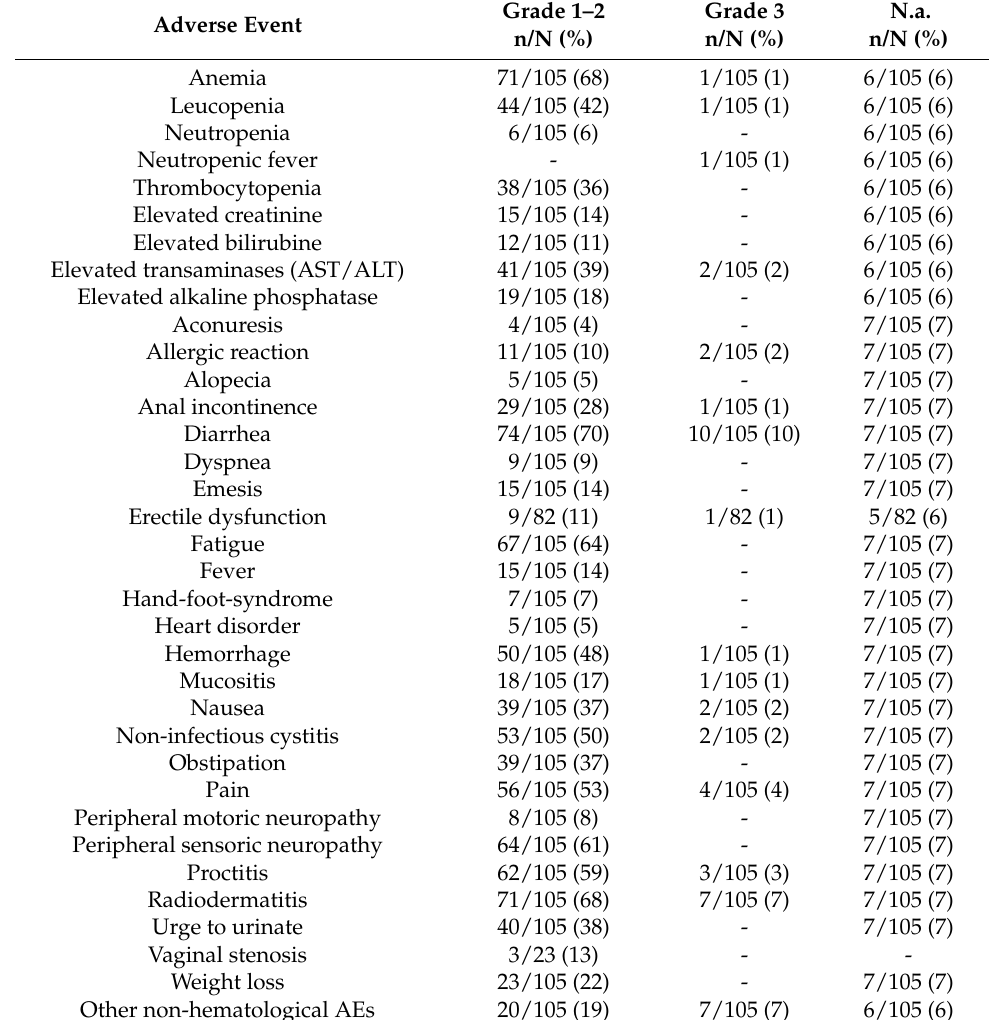
Table 4. Adverse events according to NCI CTCAE